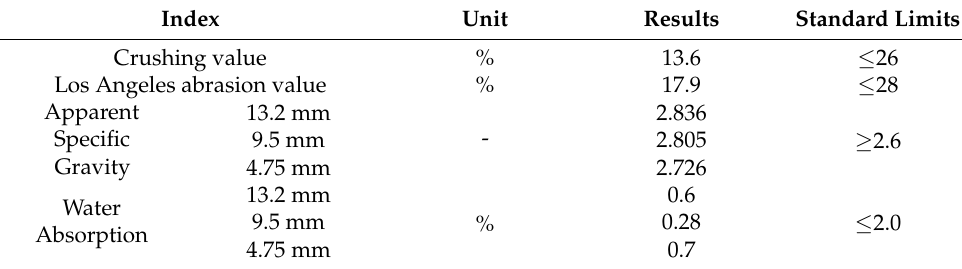
Table 2. Basic physical parameters of coarse aggregate.